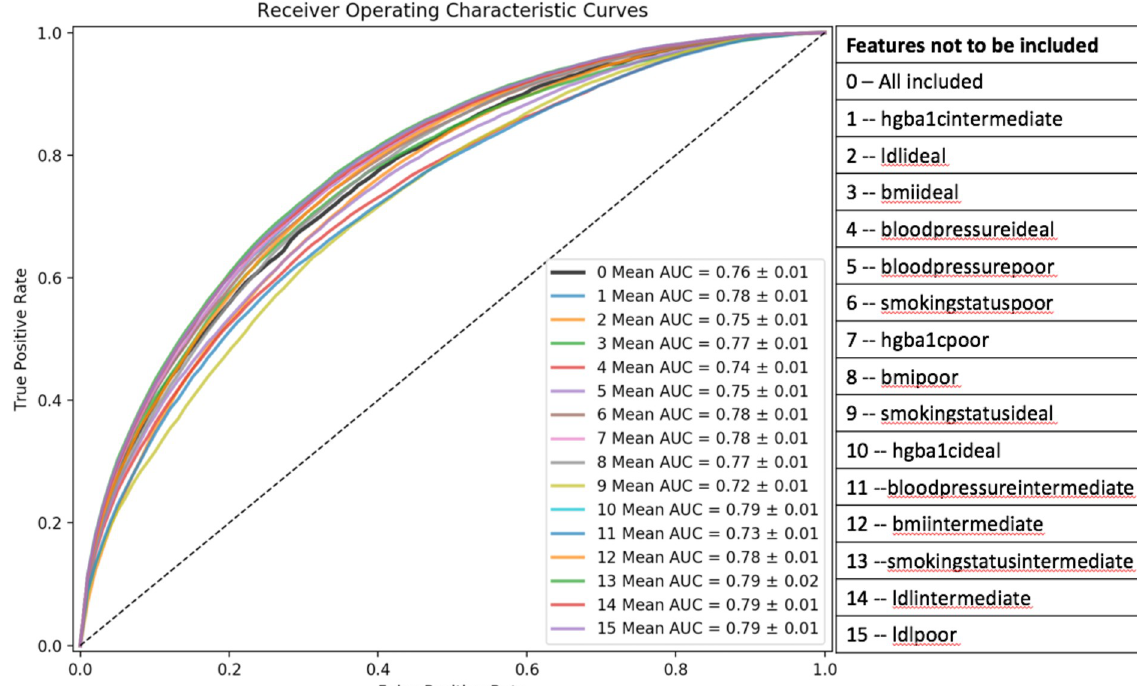
algorithm–LSTM–outperformed other traditional machine learning algorithms and achieved the best accuracy performance. Our results in which we dropped one feature at a time by set- ting it as constant from our analyses indicated that patients with ideal CVH especially blood pressure was associated with diagnosis with CD, which was consistent with results that high blood pressure and obesity might increase the chances of developing a CD. Additional risk factors that were associated with a higher prevalence of CD included female gender and white race. Our study is the first to utilize the LSTM to investigate the relationship between